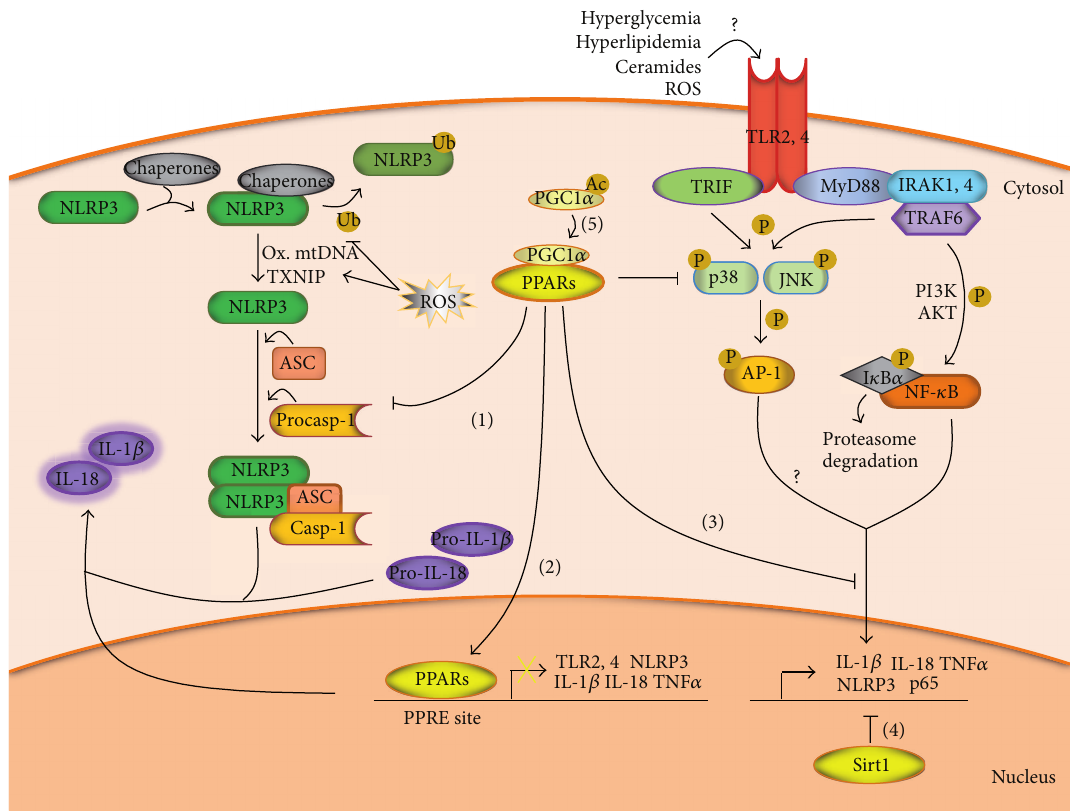
Figure 2: Crosstalk between TLRs, NLRP3 inflammasomes and dysregulated metabolic factors in DCM. PPARs and Sirt1 may control NLRP3 inflammasome and TLR pathways by interfering with the inflammasome assembly (1), proinflammatory gene overexpression (2), and NF- 𝜅 B signaling (3-4). In addition, Sirt1 could mediate PPARs activation by PGC1 𝛼 deacetylation